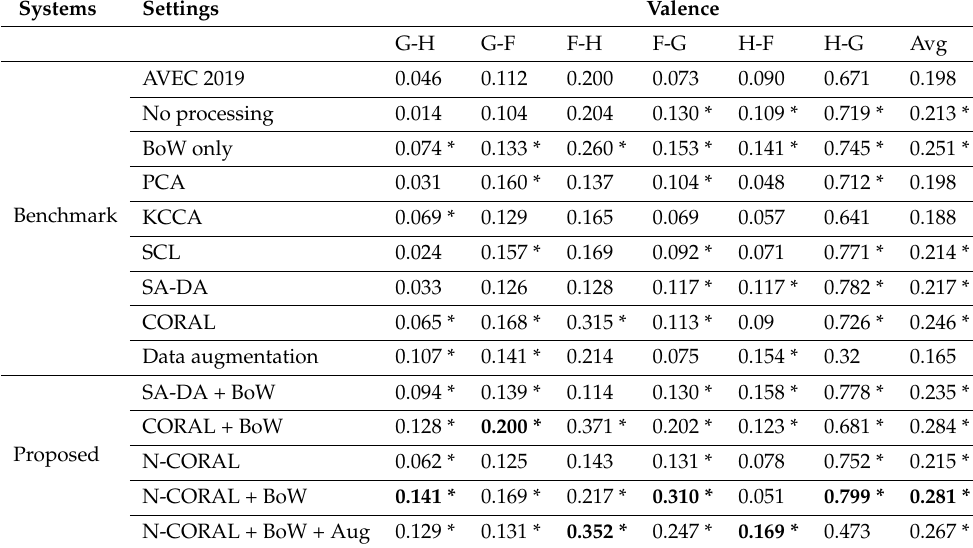
Table 3. Performance comparison of arousal estimation with different explored schemes in terms of CCC. Bi-LSTM regression was used for all methods. Highest values are indicated in bold, and significantly better results relative to benchmark are highlighted by an